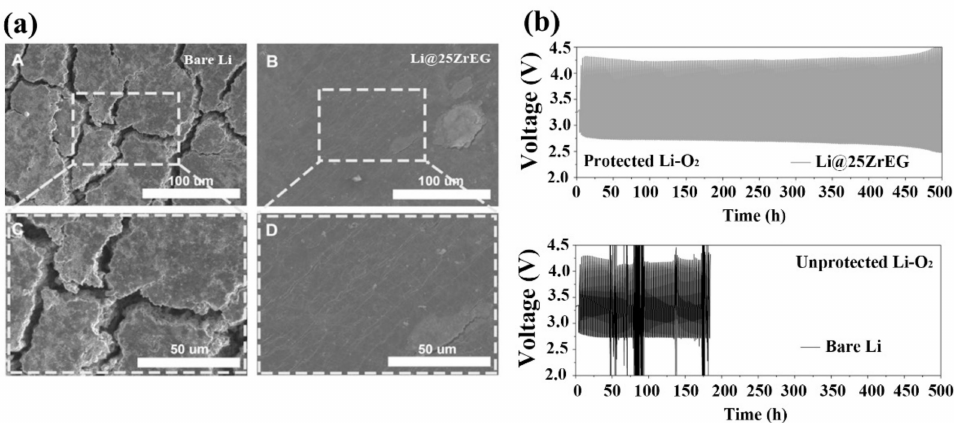
Figure 9. ( a ) Comparative SEM images of bare Li (Figure a - A and a - C ) and Li@25ZrEG (Figure a - B and a - D ) after 30 charge–discharge cycles. ( b ) Electrochemical stability of Li-O 2 cells using bare Li and Li@25ZrEG [118]. Reproduced with permission [118]. Copyright 2019,